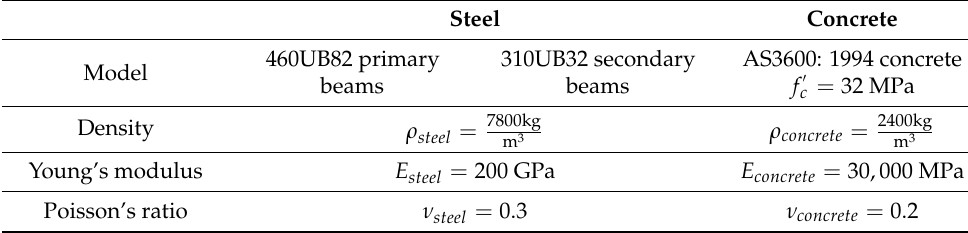
Table 4. Material properties under 4